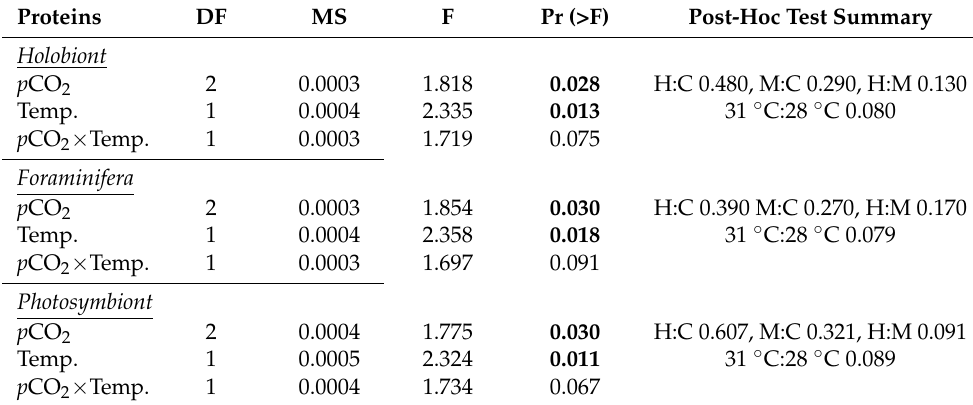
Table 2. Results of permutational multivariate analysis of variance (PERMANOVA) for all proteins, and for only host or only photosymbiont proteins of Amphistegina lobifera exposed to elevated p CO 2 (C = 492 ppm, M = 963 ppm, H = 3182 ppm) crossed with temperature (Temp.: 28 ◦ C, 31 ◦ C) for eight weeks. Pairwise comparisons of significant effects were per performed with p -values adjusted for multiple testing. Bold font indicates statistical significance ( p ≤